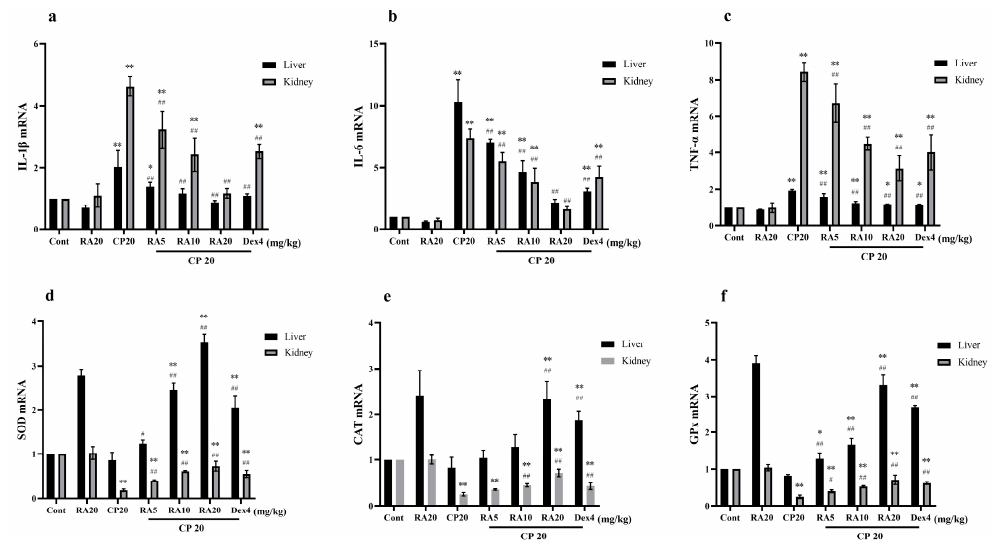
Figure 5. The effect of RA on the mRNA expression levels of IL-1 β , IL-6, TNF- α , SOD, CAT, and GPx in CP-induced acute liver and kidney injury. The mRNA expression levels of IL-1 β , IL-6, TNF- α , SOD, CAT, and GPx in the liver and kidney of mice were measured by qRT–PCR ( a – f ). These experiments were repeated three times. * and # denote significant differences ( p < 0.05) and ** and ## denote highly significant differences ( p < 0.01) compared with the control and CP model groups, respectively.